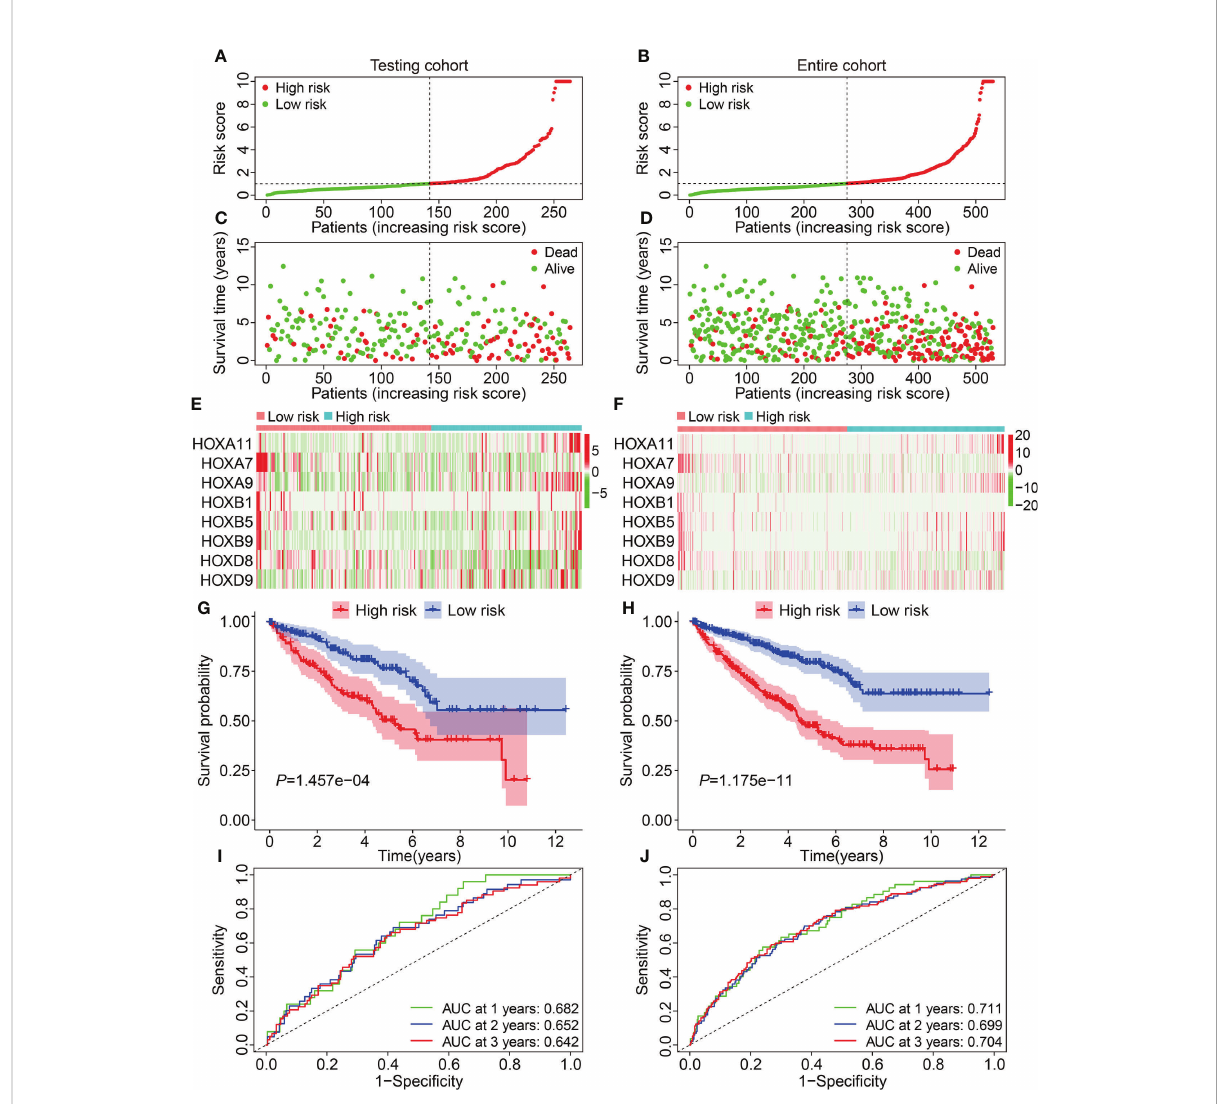
FIGURE 3 Validation of the HOX gene-based signature in internal cohorts. (A, B) The pro fi le of risk score in testing cohort and entire cohort. (C, D) The distribution of survival time and status in testing cohort and entire cohort. (E, F) The expression patterns of the eight HOX genes in testing cohort and entire cohort. (G, H) Kaplan-Meier survival curve for overall survival of patients testing cohort and entire cohort. (I, J) Time-dependent ROC curve analysis in testing cohort and entire